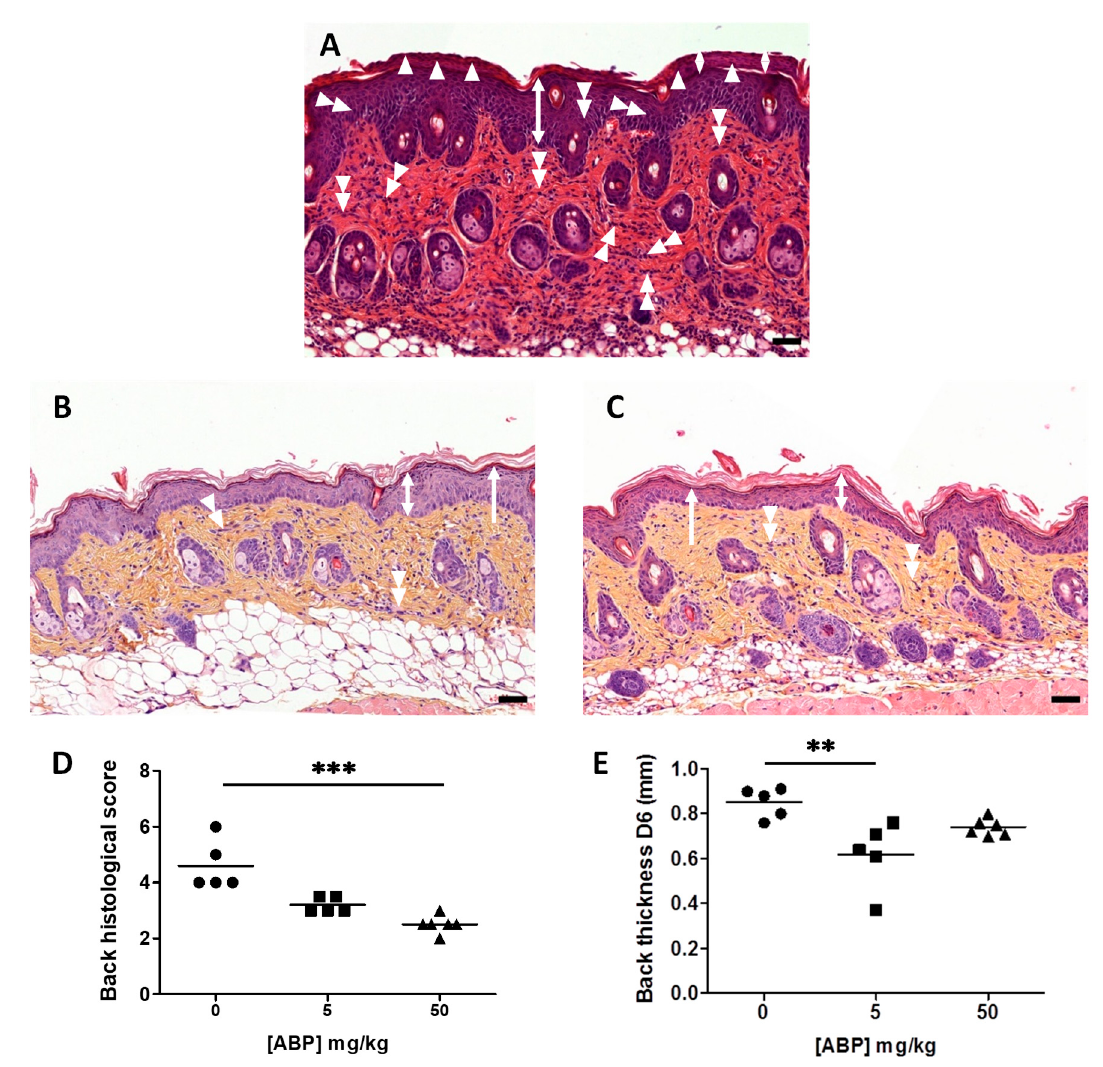
Figure 5. Histological assessment of the efficacy of the ABP dendrimer when administered topically to IMQ-induced psoriatic mice. Representative pictures of the skin of the back of mice stained with hematoxylin/eosin at day 7 from psoriatic control mouse (representative of n = 5 mice) ( A ), and from mice treated daily with 5 mg/kg (representative of n = 5 mice) ( B ) and 50 mg/kg (representative of n = 6 mice) ( C ) of the ABP dendrimer; black scale bars represent 50 µm. Single-headed arrows point the granular layer (absent in ( A )), double-headed arrows show acanthosis, single arrow heads show parakeratosis (lowered in ( B ) and ( C )), diamonds show hyperkeratosis (lowered in ( B ) and ( C )), double arrow heads show infiltration of immune cells. ( D ) Scoring of the histological assessment of the skin of the back for each group of mice; *** p < 0.001 versus untreated mice (concentration of ABP = 0 mg/kg) using the Kruskal–Wallis’ test followed by the post hoc Dunn’s test. ( E ) Measurement of the thickness of the skin of the back for each group of mice at day 6; ** p < 0.01 versus untreated mice (concentration of ABP = 0 mg/kg) using the Kruskal–Wallis’ test followed by the post hoc Dunn’s test. The same analysis performed on the dorsal skin of mice treated with the ABP dendrimer underscored a lower hyperkeratosis and no parakeratosis (this combination being defined as orthokeratosis) at the SC level. Moreover, the granular layer was perfectly visible. At the